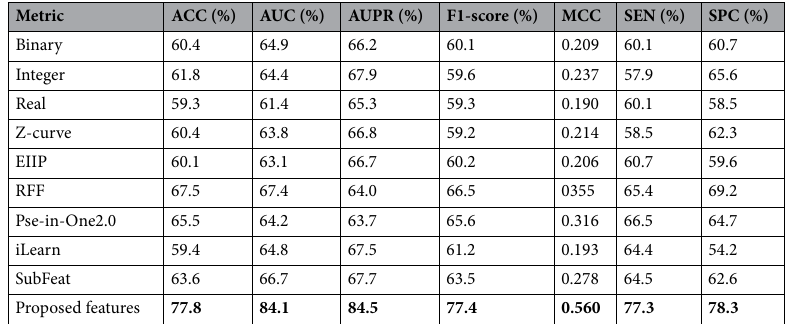
Table 7. The performance evaluation of the proposed features based on PyFeat with AB compared with other techniques: five numerical representations, RFF, Pse-in-One2.0, iLearn, and SubFeat with 10-fold cross- validation based on the lncRNA dataset. Significant values are in bold.